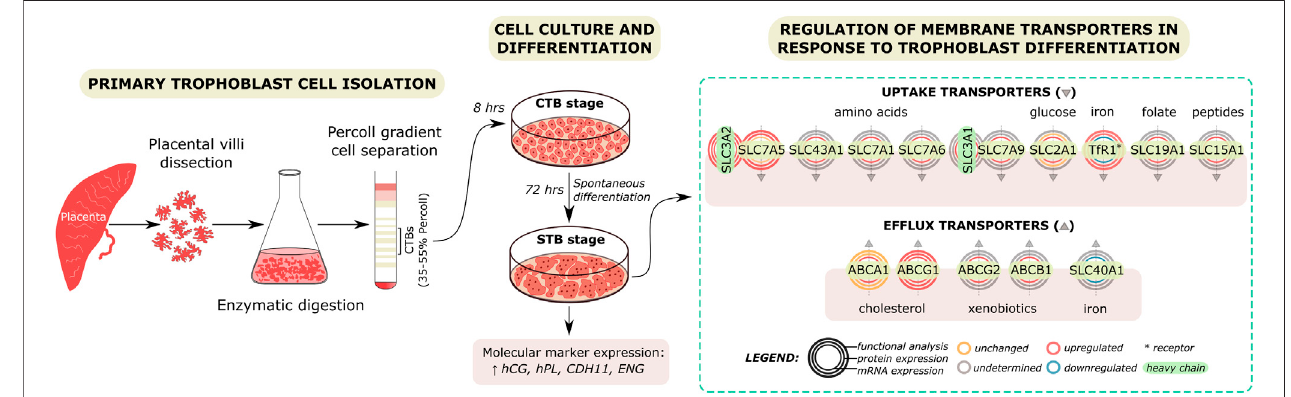
FIGURE 6 | Regulation of membrane transport protein expression and function by trophoblast differentiation. Primary trophoblast cells were isolated from the human term placenta. Dissected tissue was subjected to enzymatic digestion and Percoll gradient cell separation. Isolated cytotrophoblast (CTB) cells were cultured in vitro and allowed to spontaneously differentiate to syncytiotrophoblast (STB) over time. Experiments were carried out at a 8- or 72-h culture period, representing the CTBandSTBstages,respectively.Molecularmarkerexpressionandsecretionwereusedtocon fi rmthatcelldifferentiationwasachieved.Subsequently,theeffect of trophoblast differentiation on the expression and function of placental membrane proteins highly relevant for fetal development was evaluated. Our fi ndings reveal differential membrane transport protein function between the CTB and STB stage, likely re fl ecting their involvement in the differentiation and transport functions in individual